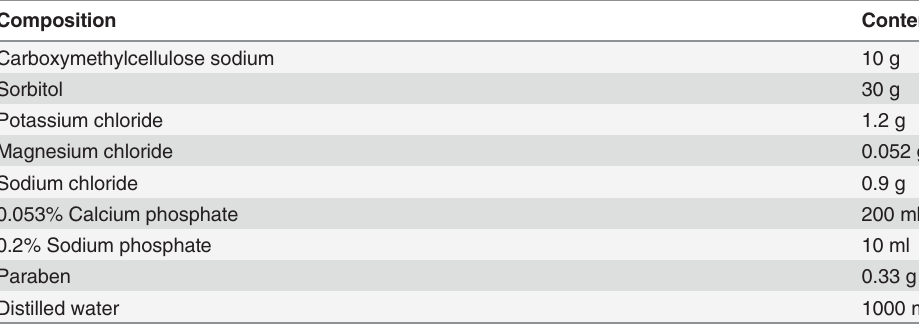
Table 3. Composition of the arti fi cial saliva